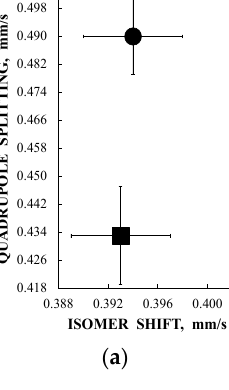
Figure 20. Plots of quadrupole splitting vs. isomer shift for quadrupole doublets 1 ( a ), 2 ( b ), 3 ( c ) and 4 ( d ) revealed in the Mössbauer spectra of the rhizobacterium Azospirillum brasilense (strain Sp245) samples 1 ( ■ ) and 2 ( • ) within the new heterogeneous model for the iron core. Data were taken from Ref. [64].